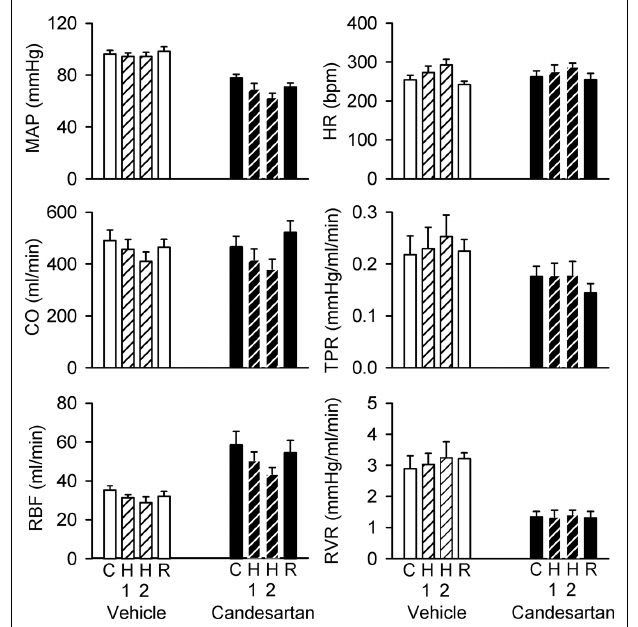
FIGURE 7 | Responses of hemodynamic variables to progressive hemorrhage in conscious rabbits treated with candesartan or its vehicle. MAP, mean arterial pressure; HR, heart rate; CO, cardiac output; RBF, renal blood flow;TPR, total peripheral resistance; RVR, renal vascular